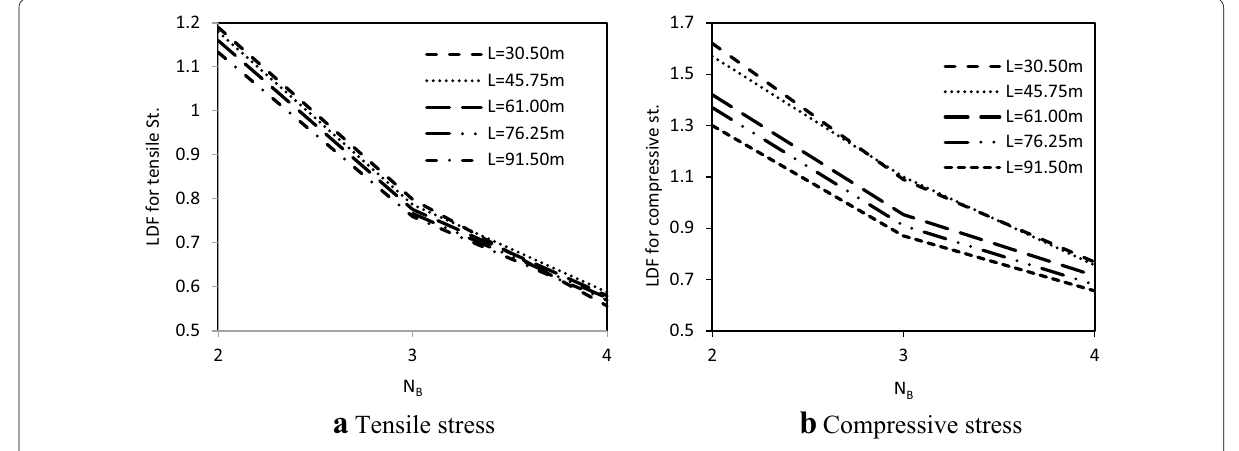
Fig. 10 Stress distribution factors for different numbers of boxes of three lane bridges.